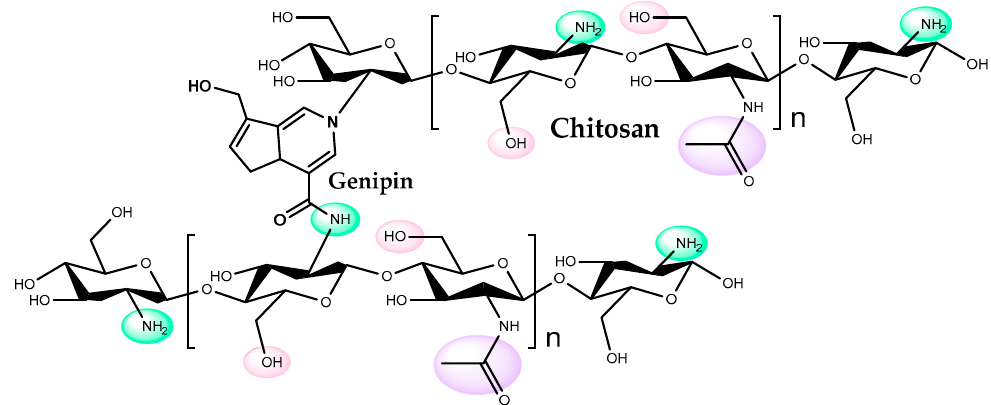
Figure 6. Schematic representation of the structure of chitosan crosslinked with genipin according to Butler et al. [63].